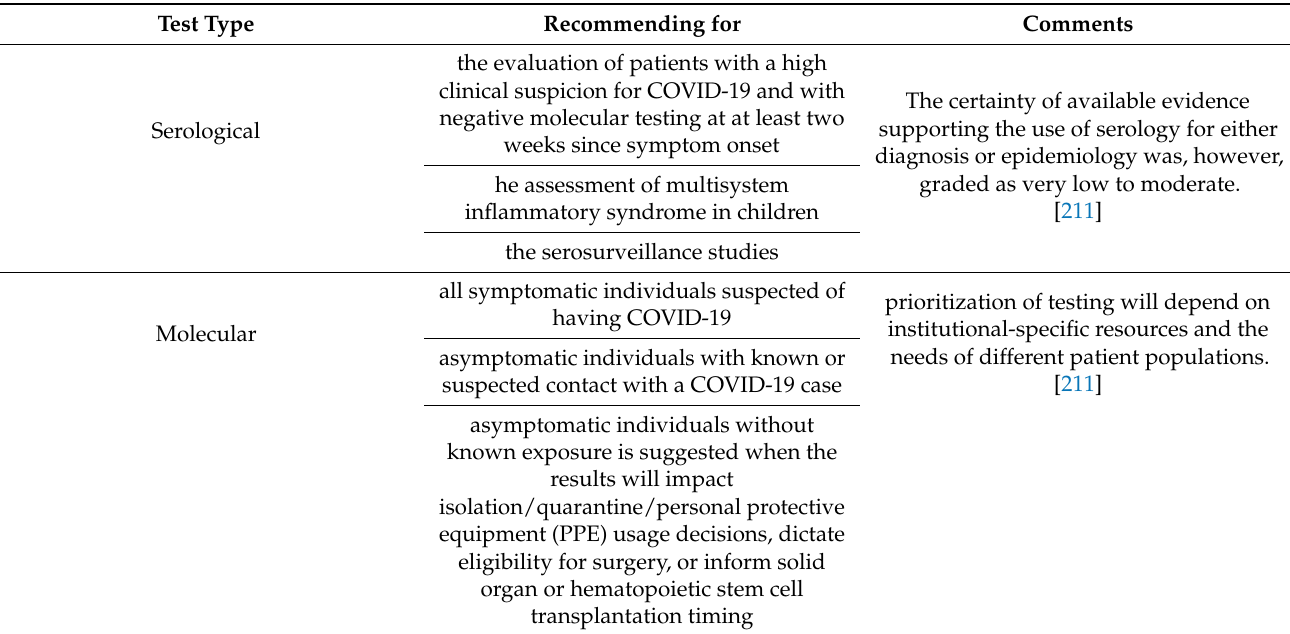
Table 4. The current IDSA recommendations for serology and molecular testing. Test